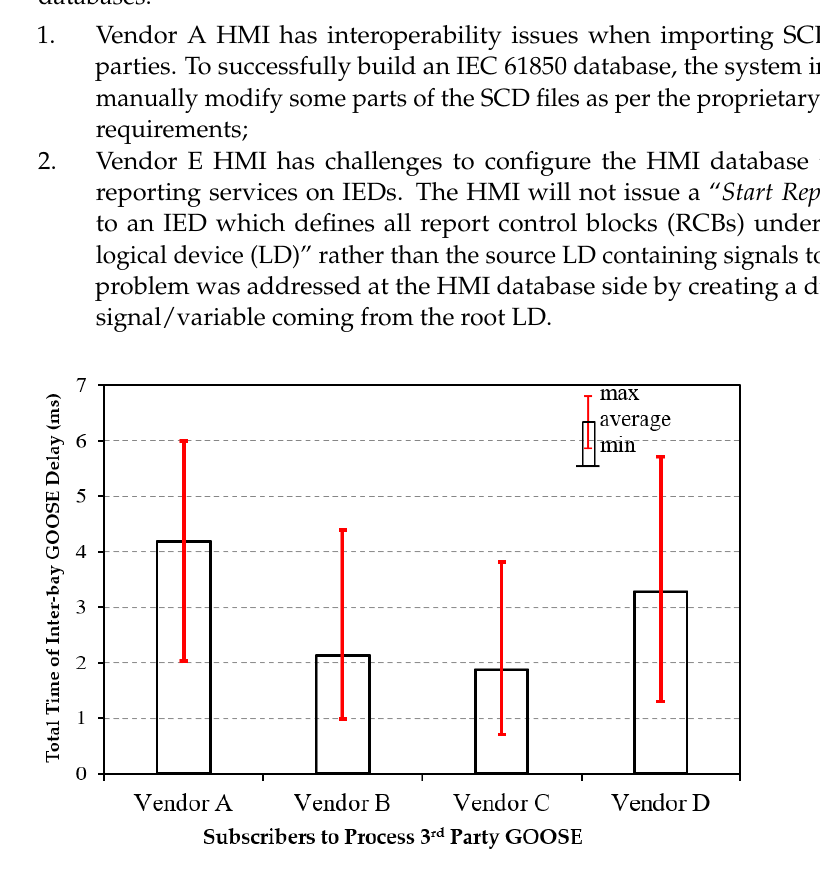
Figure 11. GOOSE transfer time via station bus (incl. processing and transit time).